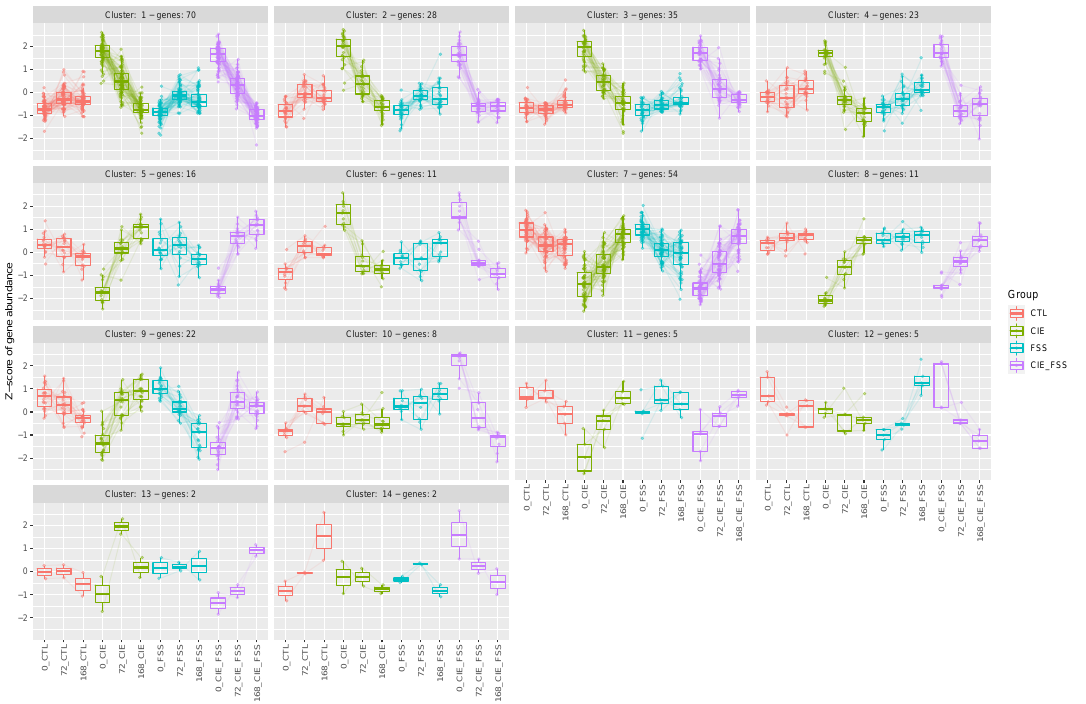
Figure 6. Cluster analysis of gene expressions to define temporal and group-wise di ff erences. Cluster analysis of 292 di ff erentially expressed genes (padj < 0.05) to define temporal and group-wise di ff erences. These clusters were produced using the degPatterns function on the regularized log transformation of the normalized counts. Each cluster represents gene expression patterns shared among di ff erentially expressed genes. Box plots are shown for the expression patterns of each gene within the group. Circles represent the number of genes in each